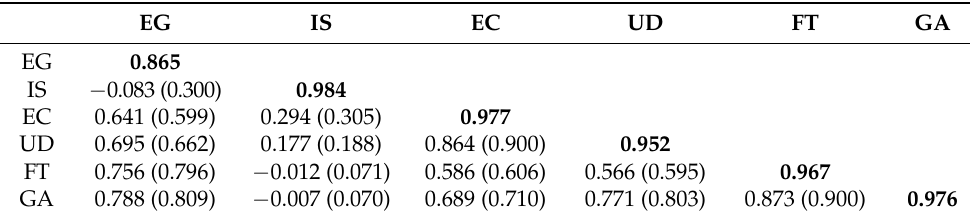
Table 3. Discriminant